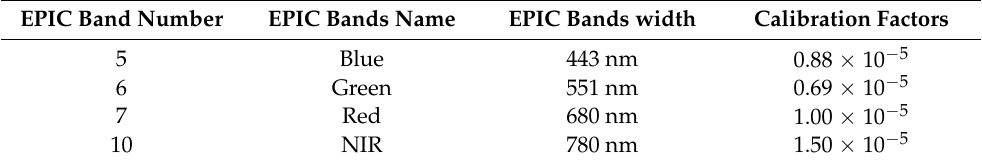
Table 1. Calibration factors for four Earth Polychromatic Imaging Camera (EPIC) spectral bands 1